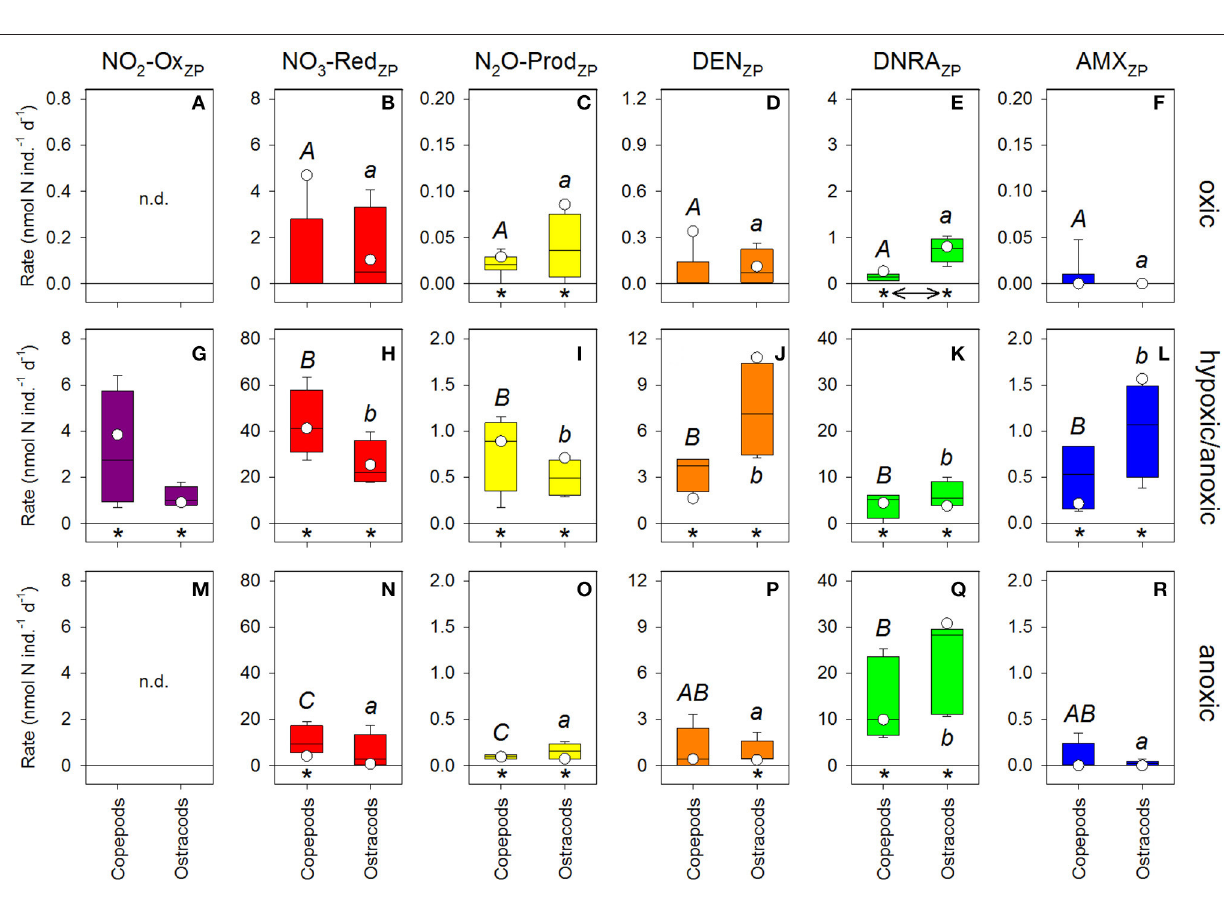
Frontiers in Marine Science |